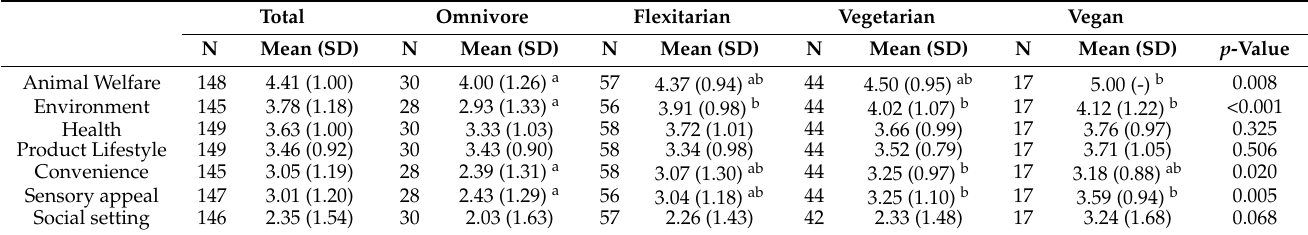
Table 7. Motives for purchasing PBMAs 1 by diet measured on a 5-point-scale (1 “totally disagree”, 5 “totally agree”).